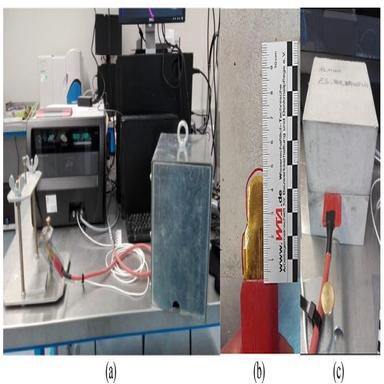
(a) Hot-Disk device, (b) top view of sensor placed on top of a sample, (c) sensor in between two samples.